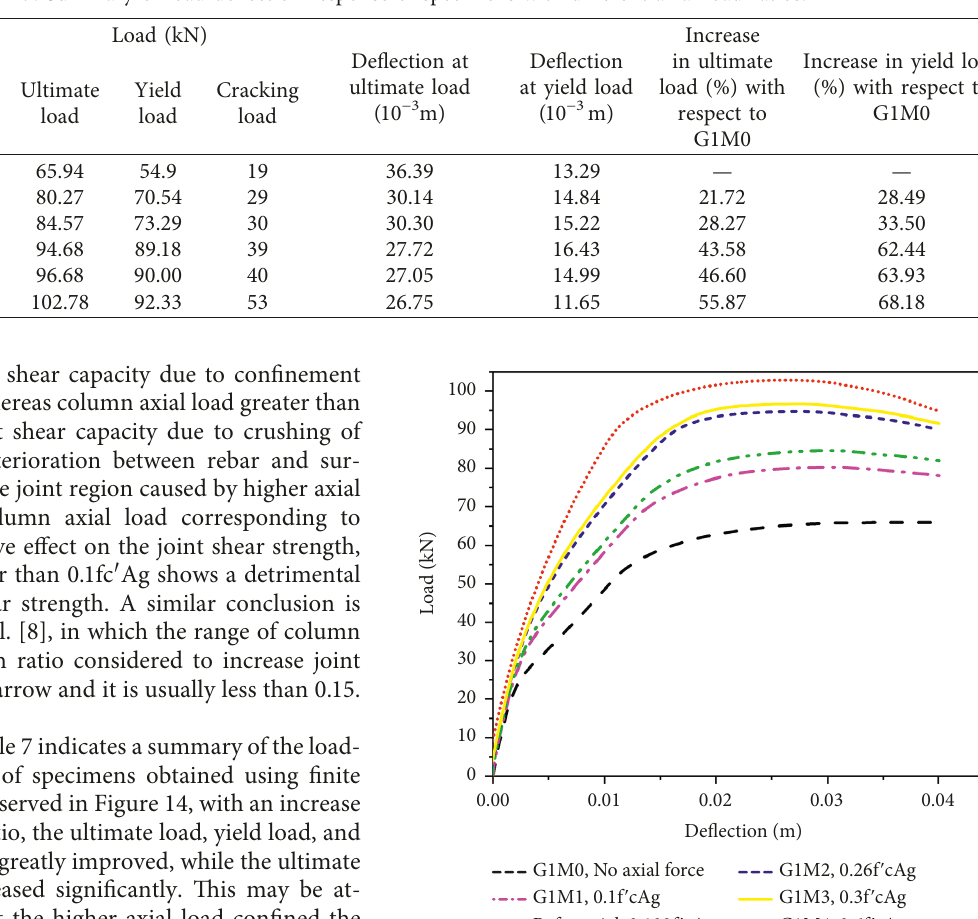
Table 7: Summary of load-deflection response of specimens with different axial load